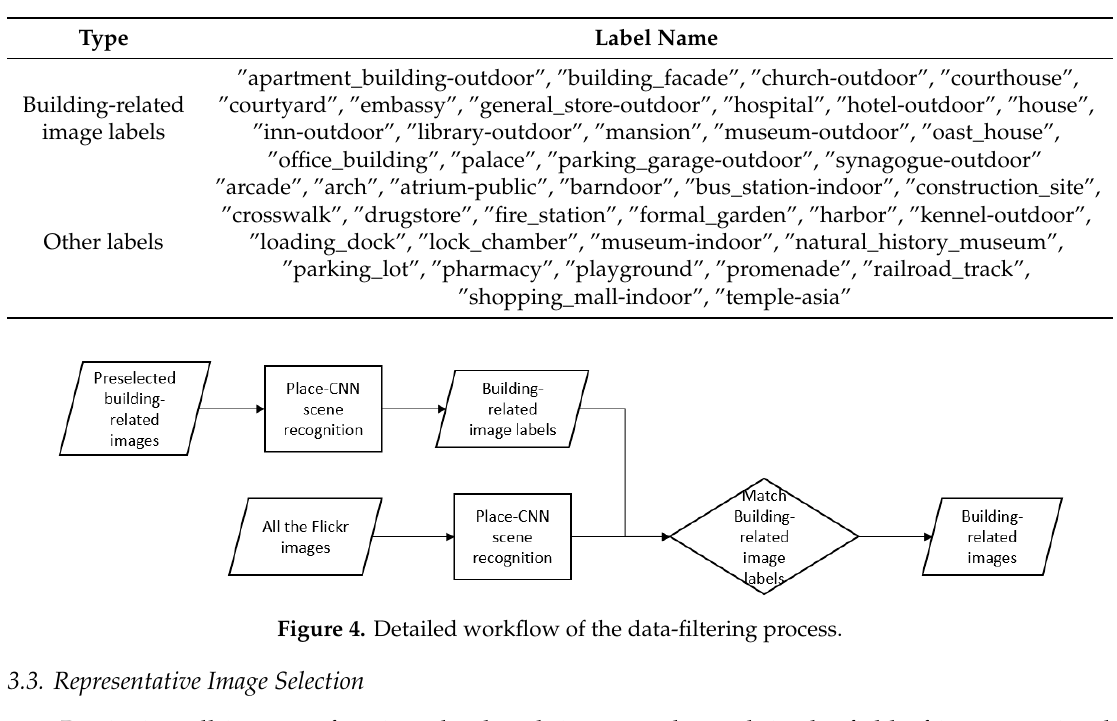
Figure 4. Detailed workflow of the data-filtering process.